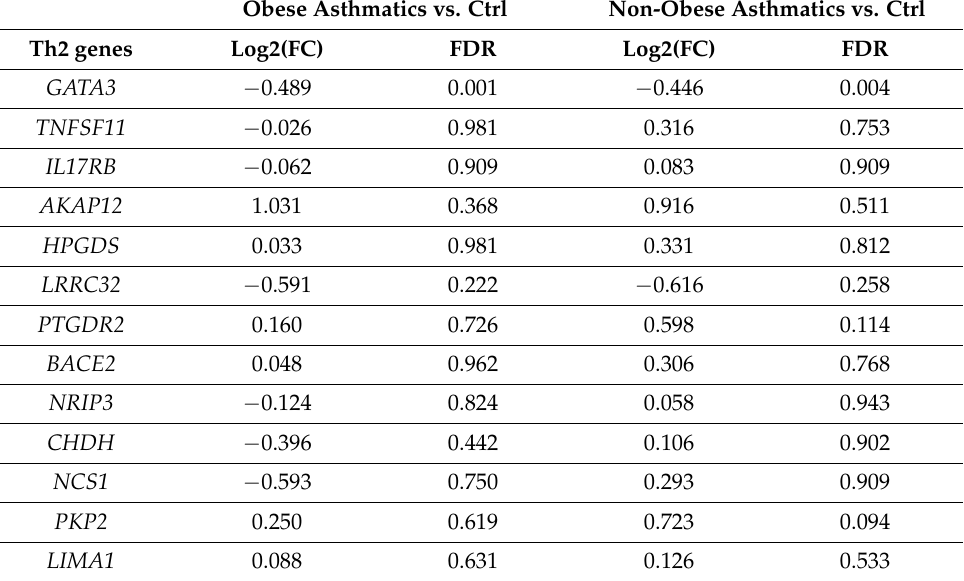
Table 2. Selected type-2-related genes and their corresponding fold change (FC) and false discovery rate (FDR) values in both comparisons, obese asthmatics vs. Ctrl (healthy controls) and non-obese asthmatics vs. Ctrl. Obese Asthmatics vs. Ctrl Non-Obese Asthmatics vs. Ctrl Th2